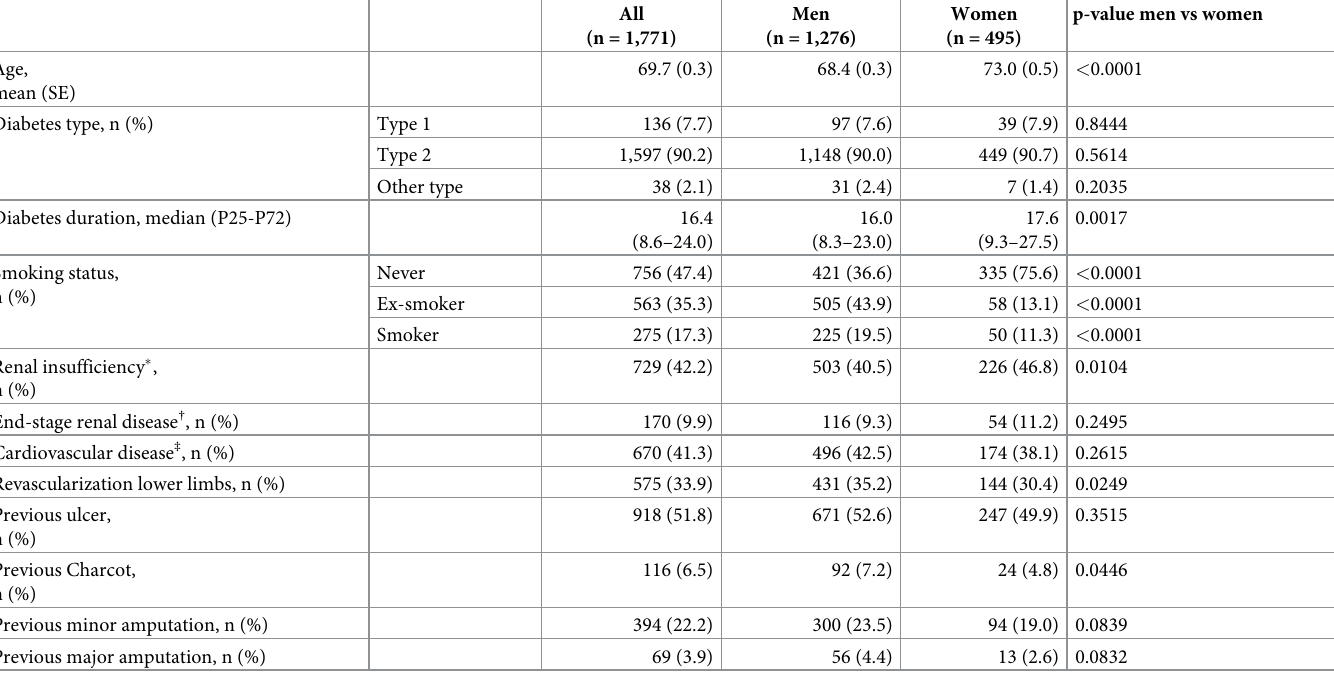
Table 1. Characteristics and medical history of patients at